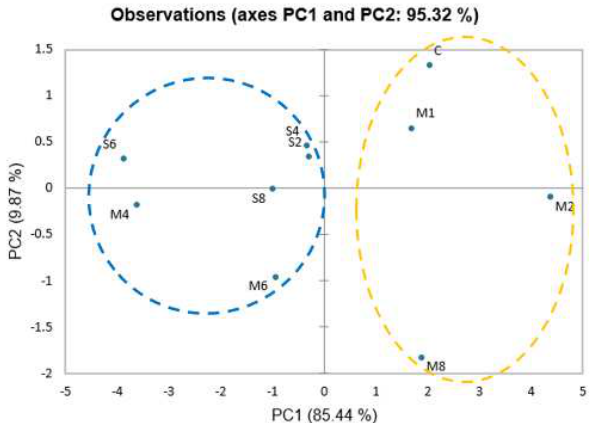
Figure 4. PCA score plots of taste attributes based on E-tongue in control unseasoned soup, unsea- soned soup containing 0.2–0.8% SGM, and unseasoned soup containing 0.1–0.8% MSG. All samples were grouped based on cluster analysis and delineated by blue and yellow ovals ( p ≤ 0.05), where C: